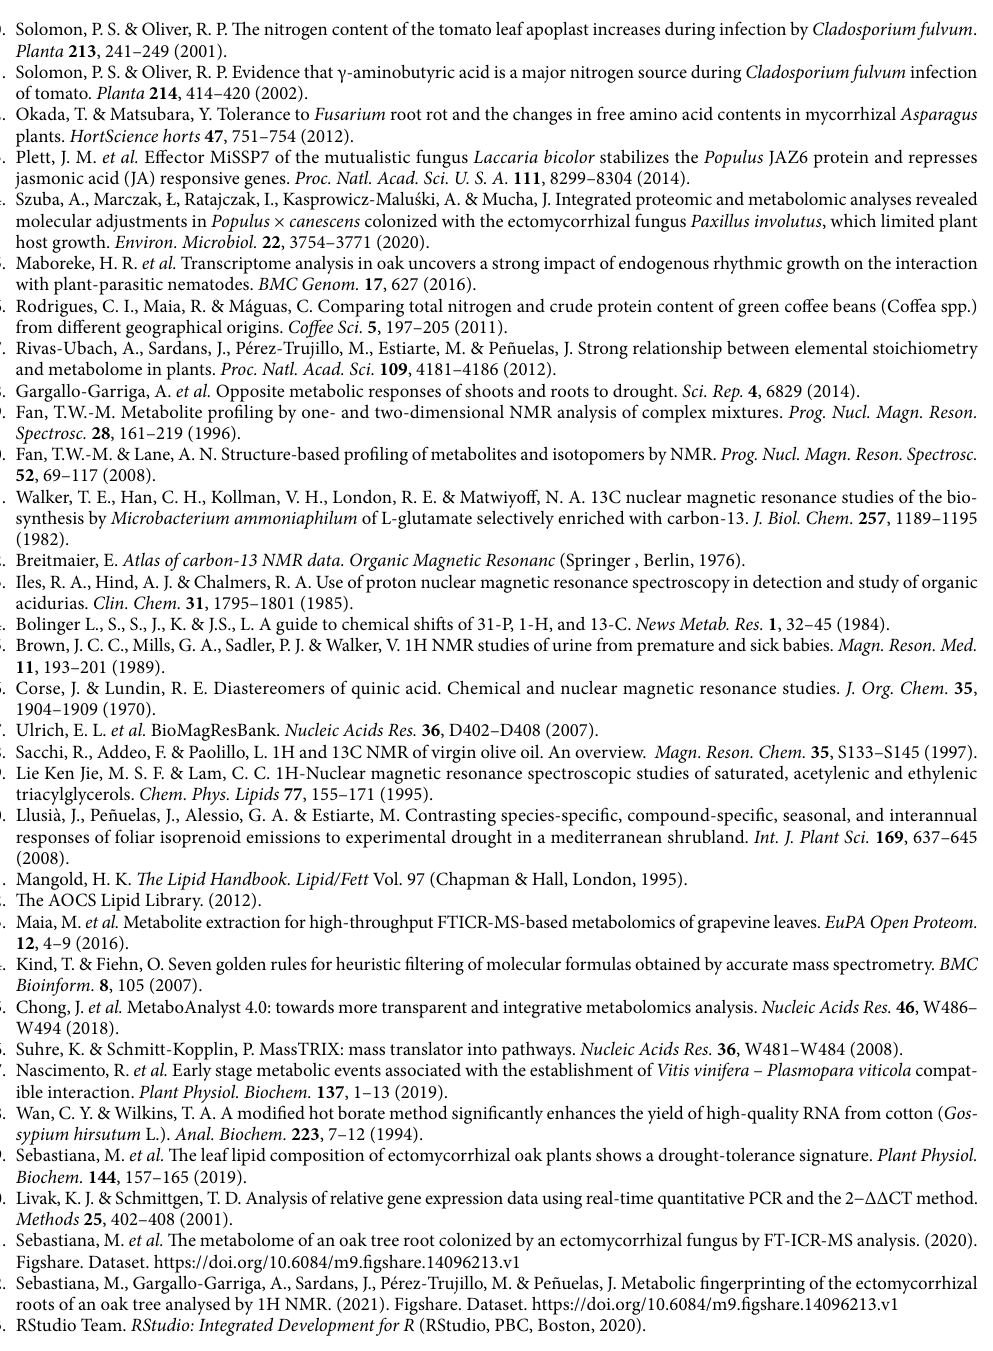
Figshare. Dataset. https://doi.org/10.6084/m9.figshare.14096213.v1 82. Sebastiana, M., Gargallo-Garriga, A., Sardans, J., Pérez-Trujillo, M. & Peñuelas, J. Metabolic fingerprinting of the ectomycorrhizal roots of an oak tree analysed by 1H NMR. (2021). Figshare. Dataset. https://doi.org/10.6084/m9.figshare.14096213.v1 83. RStudio Team. RStudio: Integrated Development for R (RStudio, PBC, Boston,